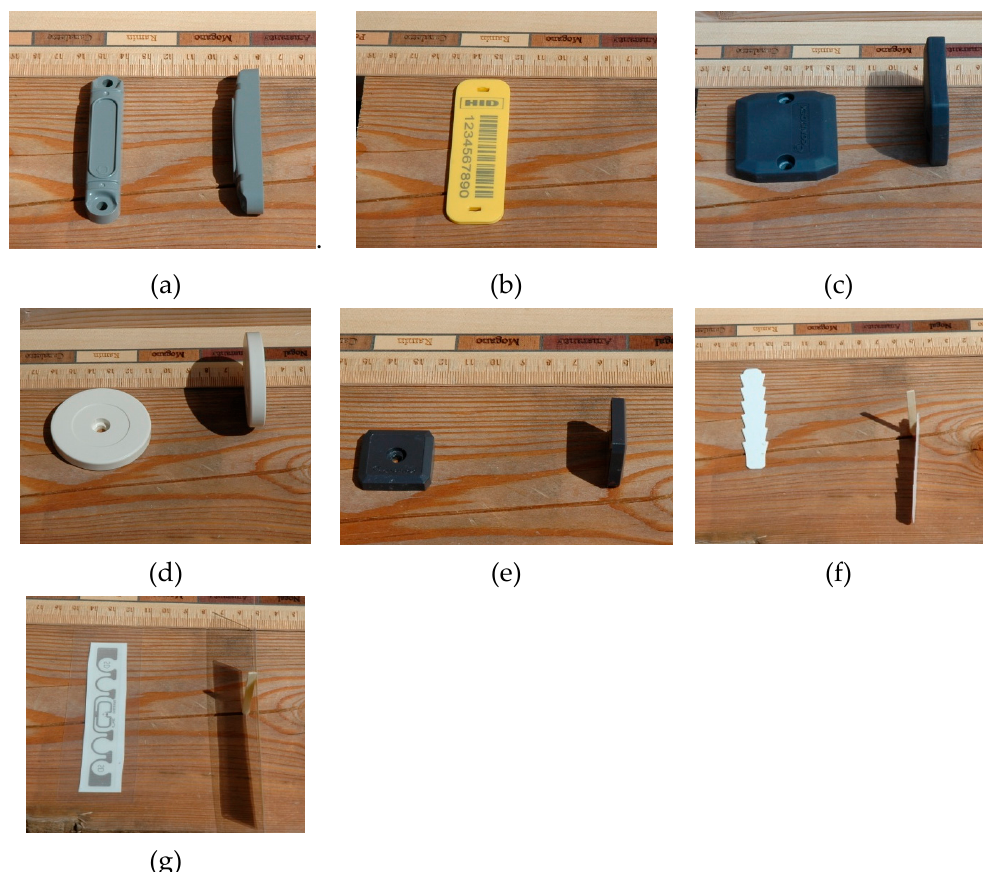
Figure 1. RFID tags used to mark standing trees: ( a ) OE, ( b ) HS, ( c ) CI, ( d ) SY, ( e ) CIM, ( f ) CP, ( g ) SS.